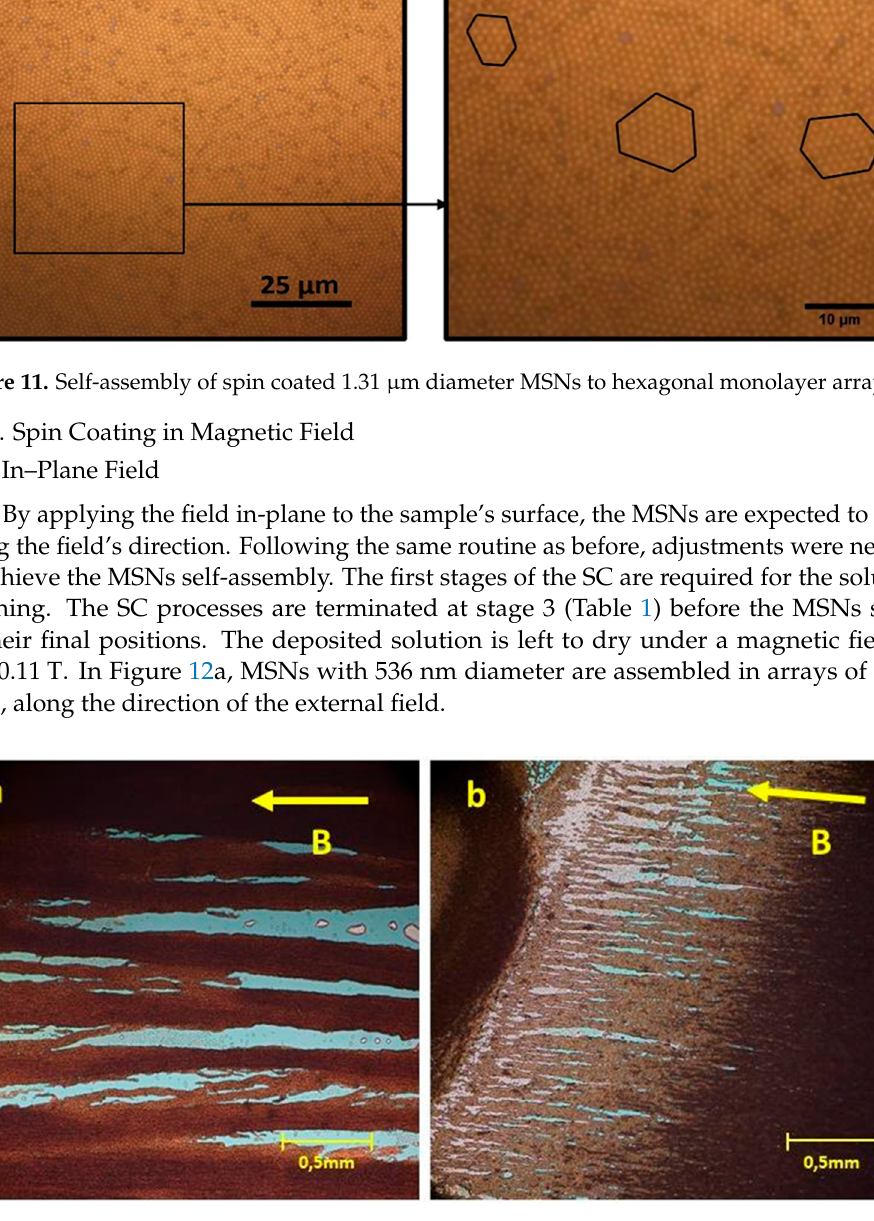
Figure 12. MSNs configurations obtained by drying ex-situ under the application of an in-plane magnetic field following spin-coating deposition of their aqueous solutions: ( a ) 536 nm diameter and ( b ) 1.31 μ m diameter.